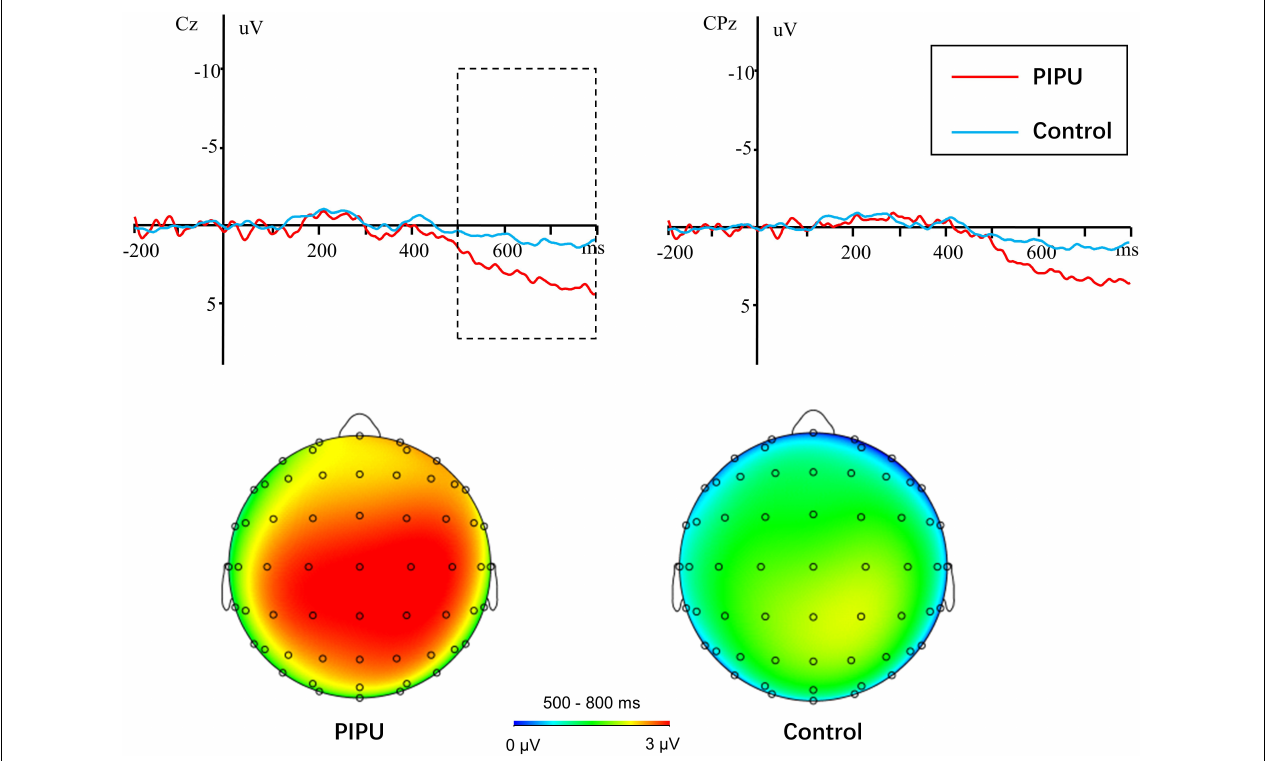
FIGURE 2 | Novel-familiar difference waves in individuals with high tendencies toward PIPU vs. low tendencies and their topographical maps during the 500–800 ms time